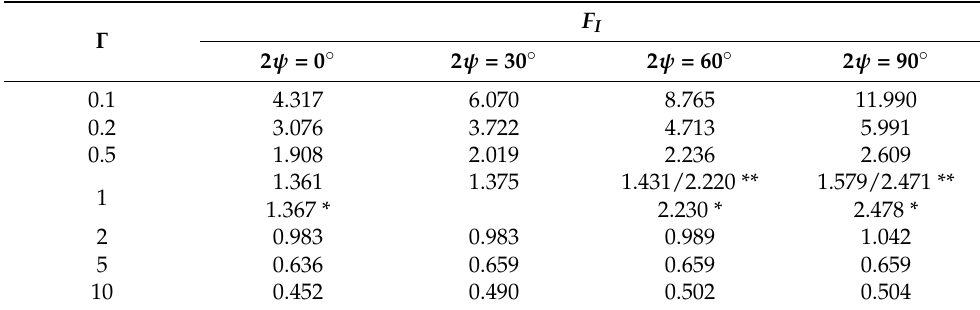
Table 3. Values of normalised stress intensity factors F I calculated for a rectangular plate with a single edge sharp corner under uniaxial tension, a / w =